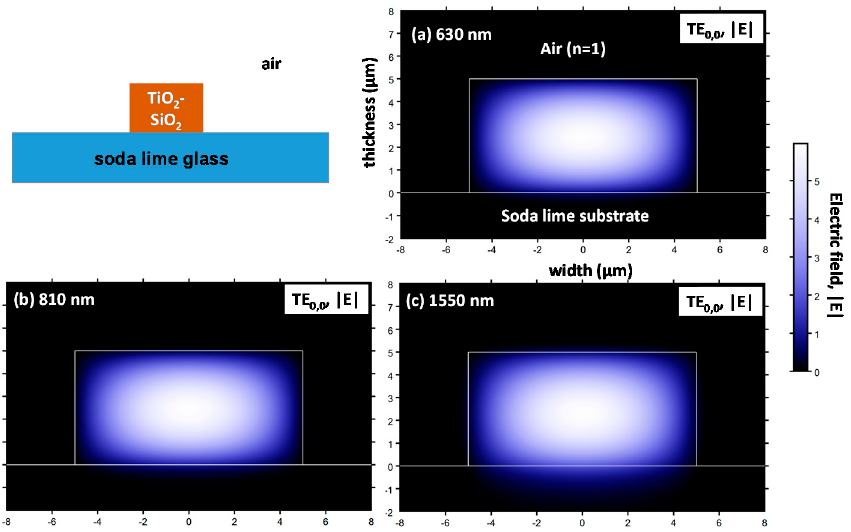
Figure 12. Simulated transverse electric TE 00 mode of a TiO 2 –SiO 2 waveguide deposited on a soda- lime glass surrounded by air and operating at ( a ) 630 nm, ( b ) 810 nm and ( c ) 1550 nm. The thicknesses and widths are 5 µm and 10 µm, respectively.